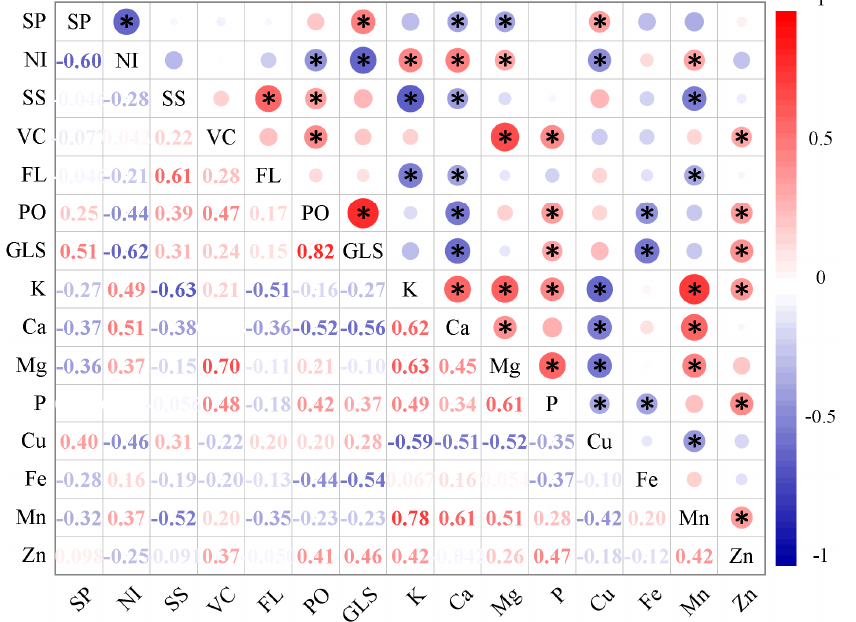
Figure 2. Heatmap showing Pearson correlation analysis between parameters of quality, antioxidant properties, and minerals. The values are Pearson correlation coefficients (* correlation is significant at p ≤ 0.05). The size and color depth of the colored circles correspond to the strength of the correlation, ranging from weak (small ball, blue) to strong (large ball, red). The full name of each trait abbreviation can be found in Table 3.